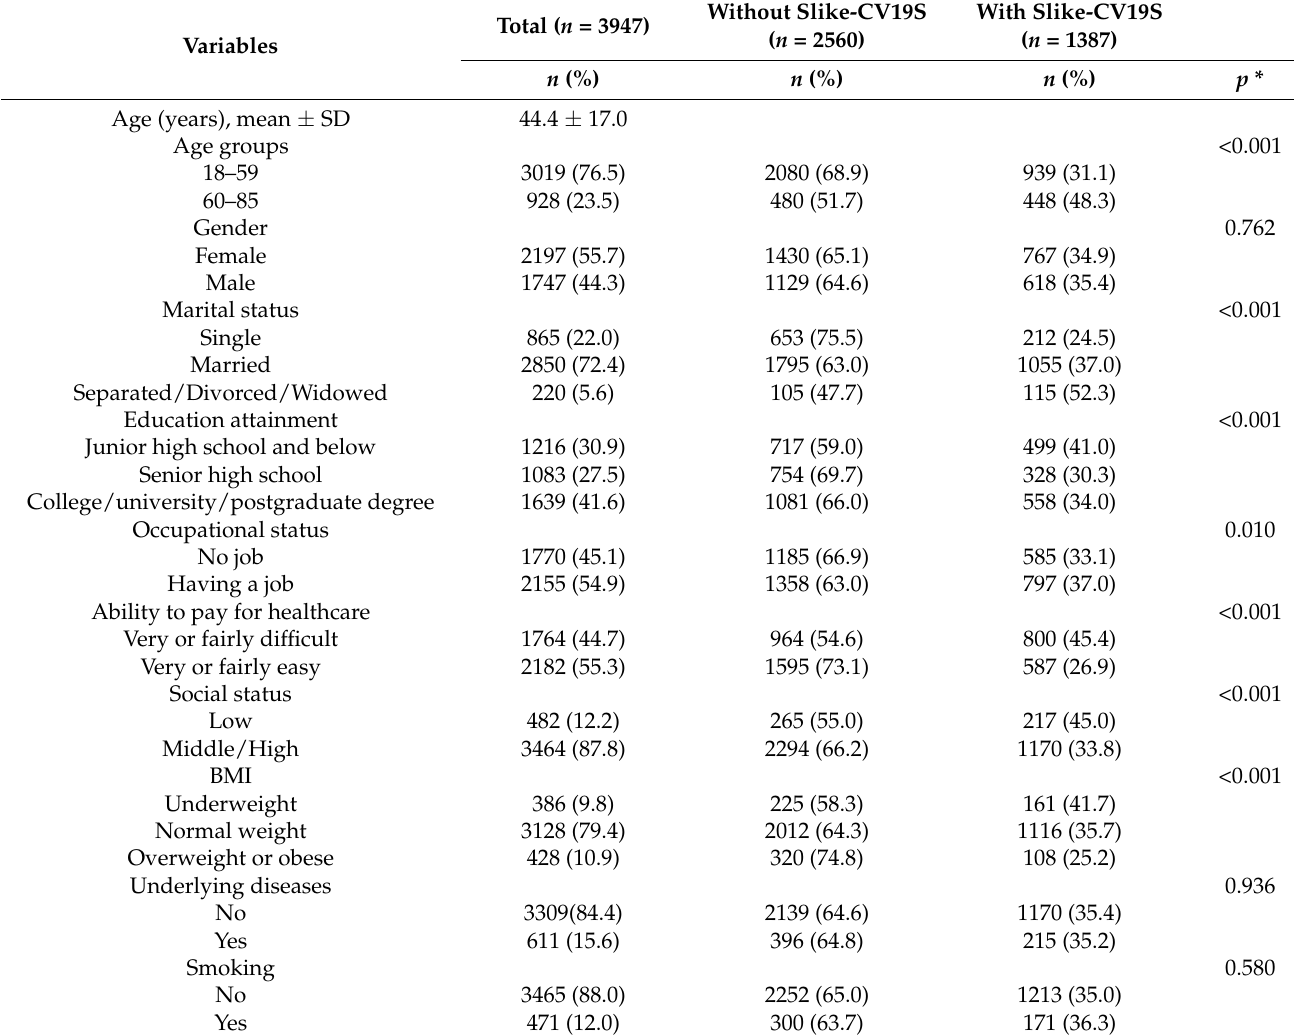
Table 1. Characteristics of participants ( N =